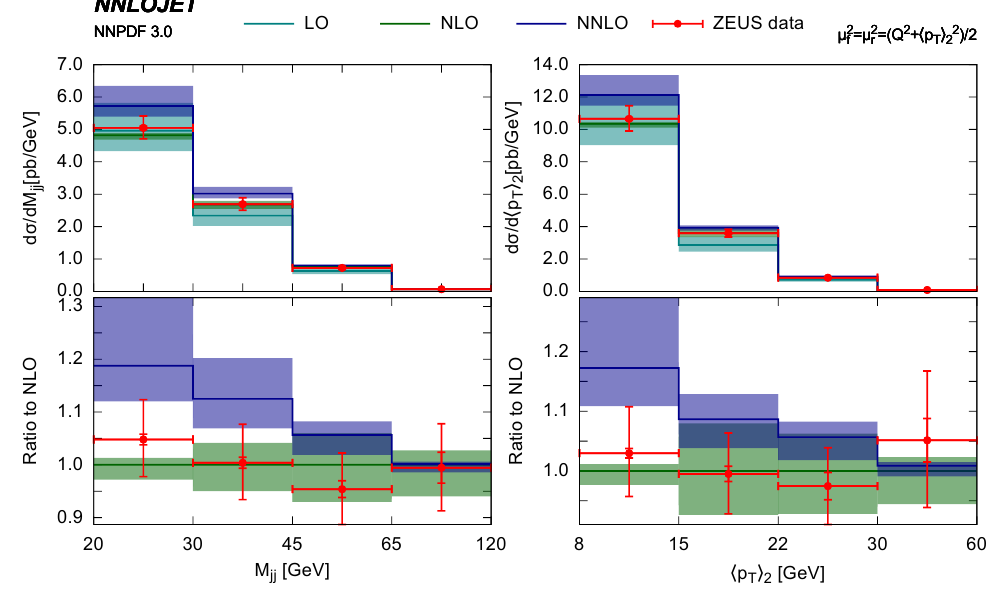
Figure 9 . Inclusive di-jet production cross section as a function of h p B compared to ZEUS